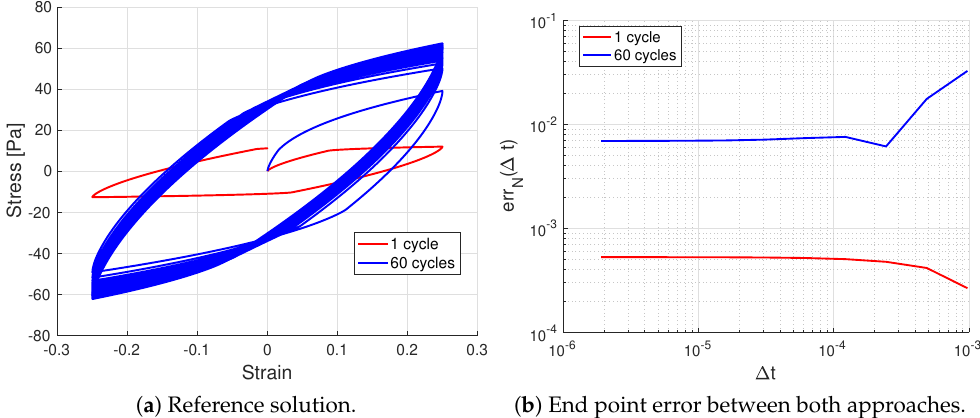
( b ) End point error between both approaches. Figure 6. Comparison between the presented return-mapping algorithm and the reference approach from [14] under low- and high-frequency loading.